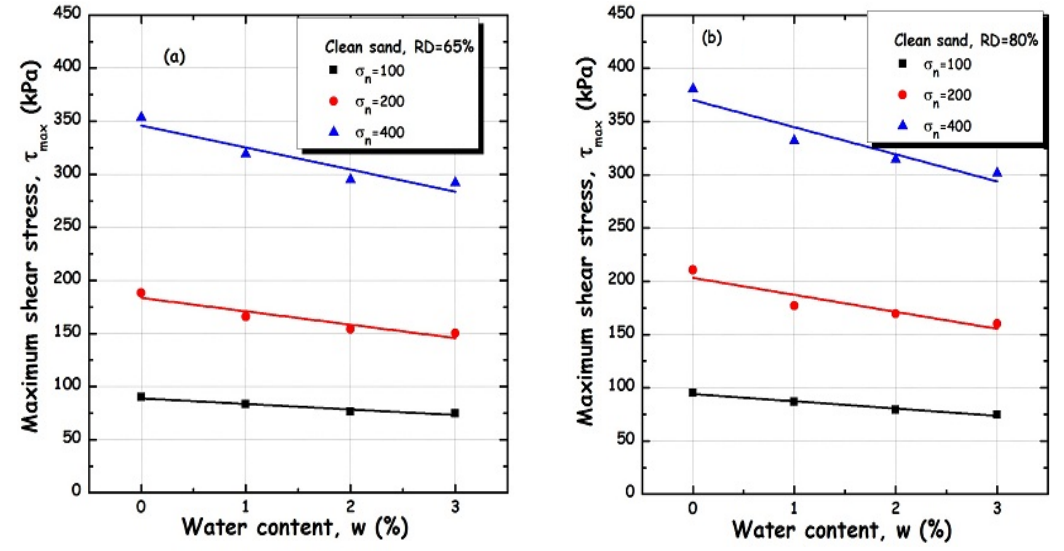
Figure 16: Effect of water content on the mechanical behaviour of clean sand: (a) RD = 65%, (b) RD = 80%.